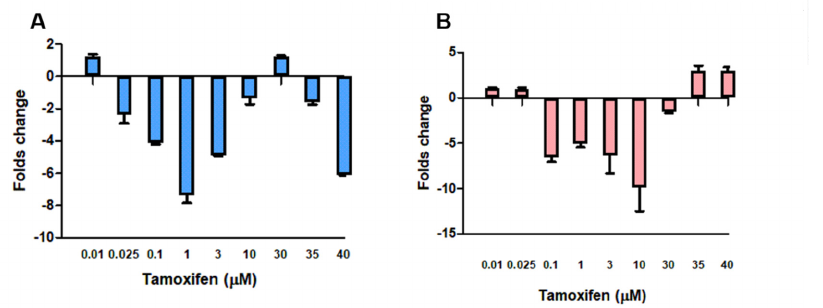
Figure 2. Fold changes in gene expression of ( A ) LDHA and ( B ) LDHB from MCF-7 cells treated with increasing doses of tamoxifen. Gene expression concentration results were expressed as mean ± SD ( n = 3 runs for each sample).